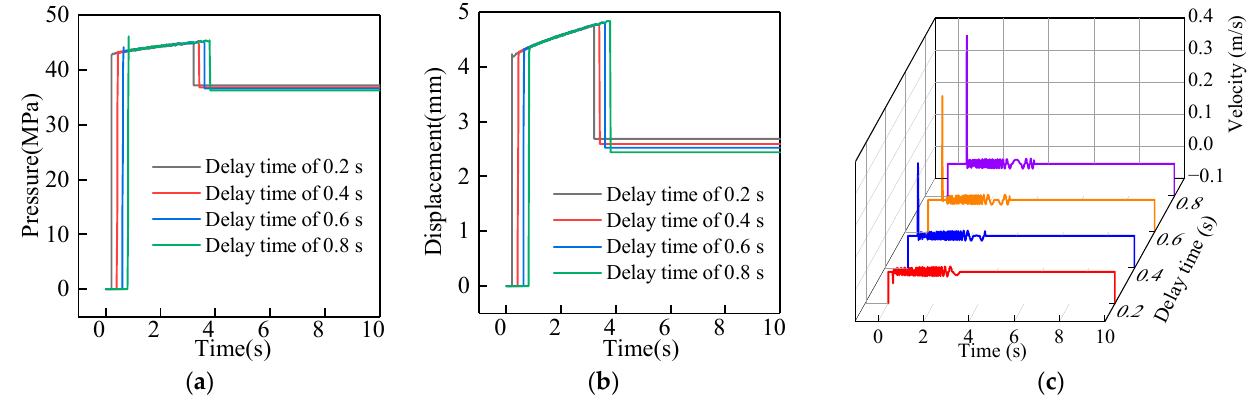
Figure 13. ( a ) Relief valve pressure. ( b ) Displacement at the spool. ( c ) Velocity at the spool.